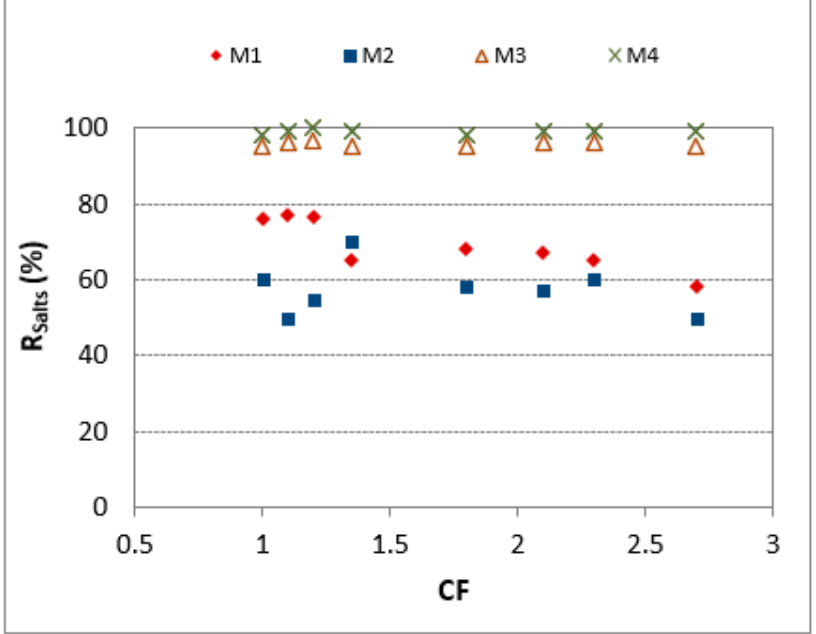
Figure 8. Influence of concentration factor (CF) on R Salt .